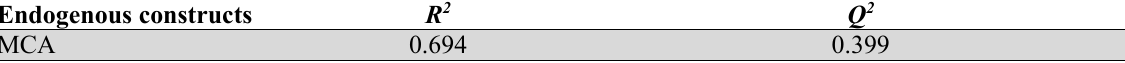
Predictive Relevance of the Endogenous